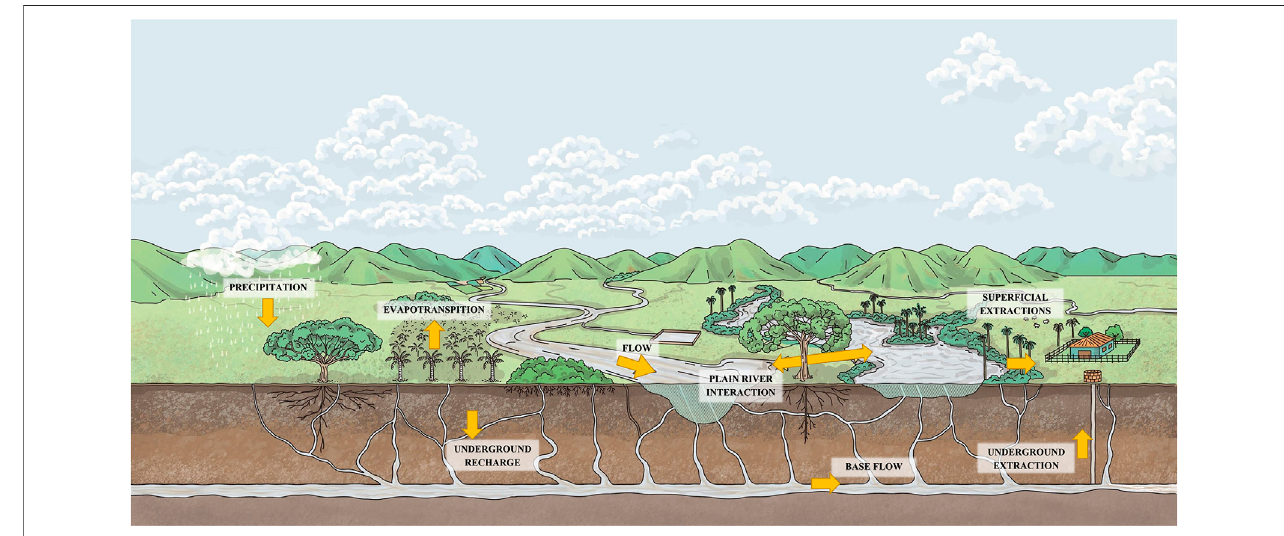
FIGURE 2 | Conceptual diagram of the hydrological